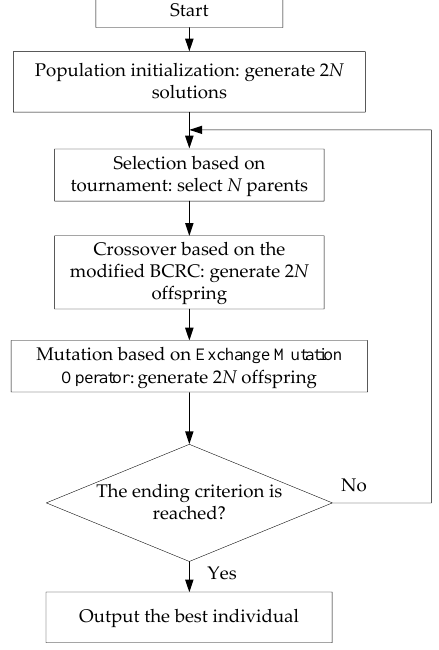
Figure 3. The flow chart of HGA.